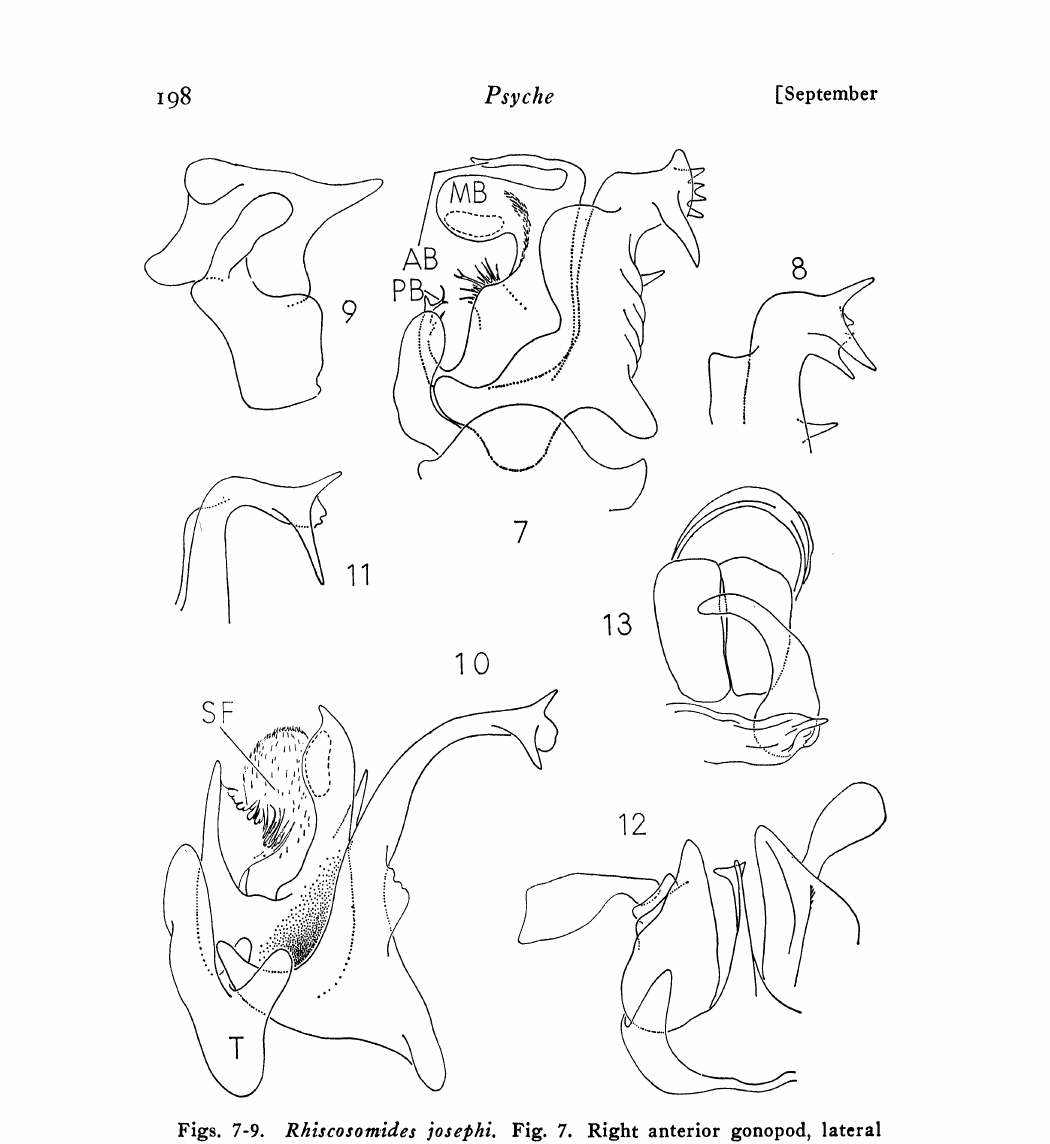
Figs. 7-9. Rhiscosomides )osethi. Fig. 7. Right anterior gonopod, lateral view. Fig. 8. Termination of gonopod of variant specimen, lateral view. F’ig. 9. Left posterior gonopod, anterior view. Figs. 10-13. R. benedictae. Fig. 10. Right anterior gonopod, lateral view. Fig. 11. Termination of gonopod of variant specimen, lateral view. Fig. 12. Sternum and eoxae of legs 2 of female, posterior view. Fig. 13. Left eyphop.od and postgenital structure, posterior